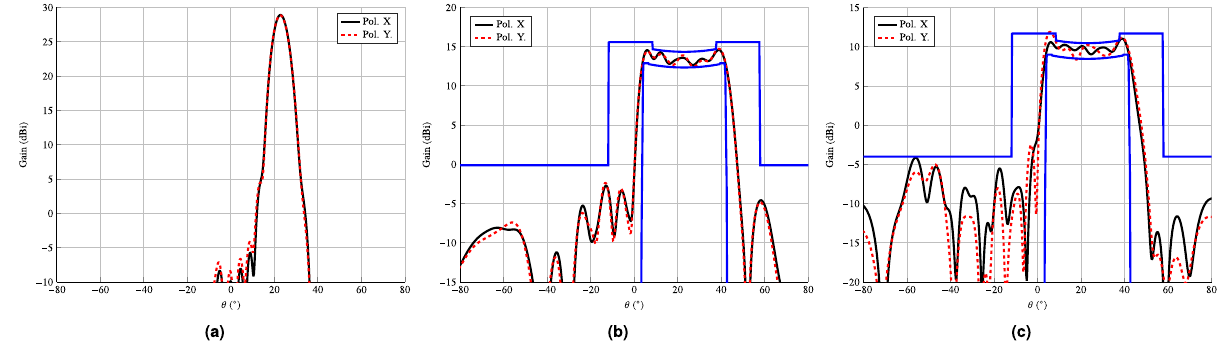
Figure 8. Radiation patterns corresponding to the phase-shift distributions shown in Fig. 7. (a) Pencil beam pointing at ( θ 0 , ϕ 0 ) = ( 23 ◦ , 0 ◦ ). ( b ) Isoflux pattern obtained using an ideal cos q θ model for the feed horn. ( c ) Isoflux pattern obtained using the spherical wave expansion model for the feed horn.